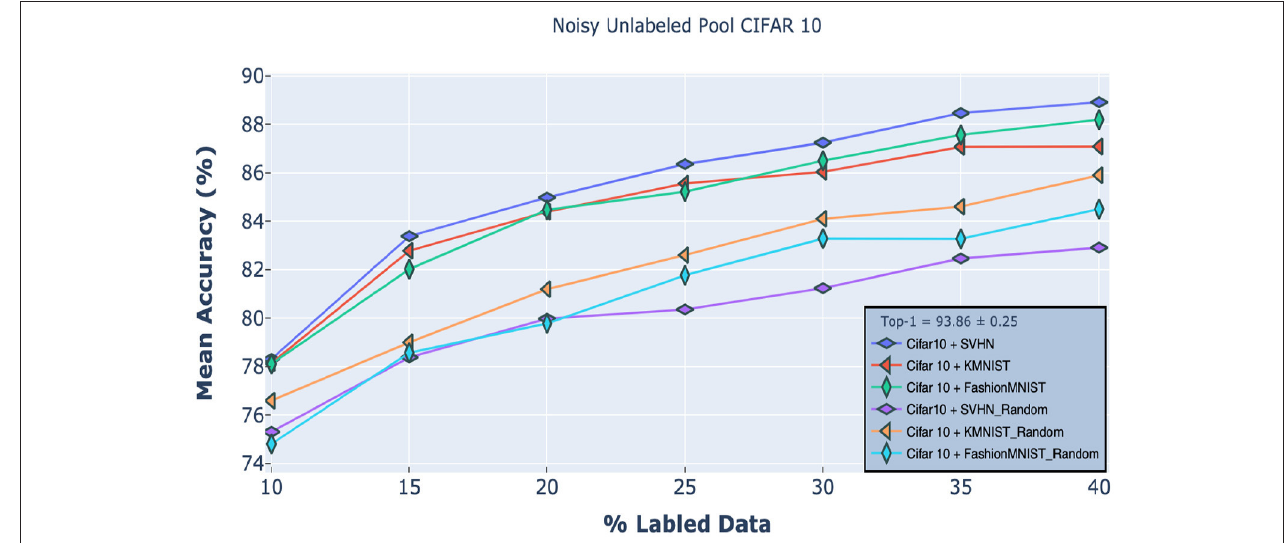
FIGURE 7 | Robustness of our approach on CIFAR10 classification tasks when the unlabeled pool includes samples from either the SVHN, KMNIST, or FashionMNIST datasets. The first three curves used the M 2 classifier, while the ones with the “Random” subscript used random sampling. Our results confirm that our approach significantly outperforms this baseline.